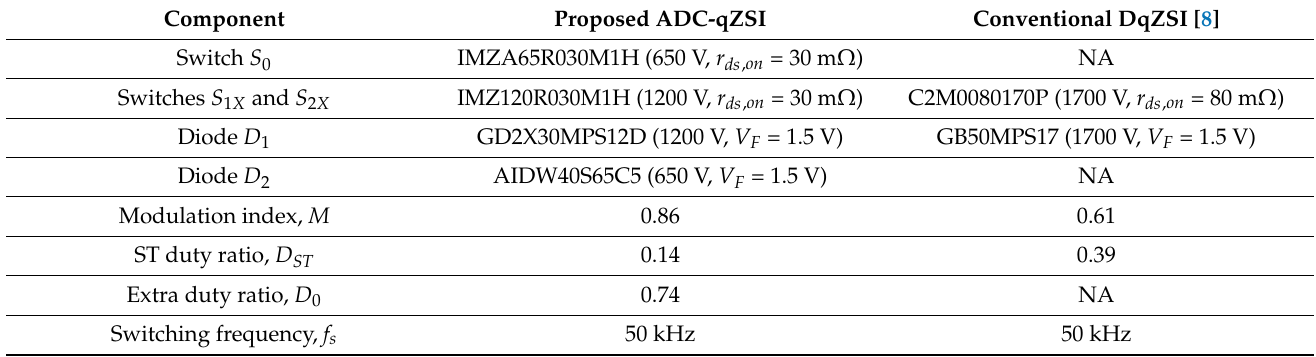
Table 2. Semiconductor and operating